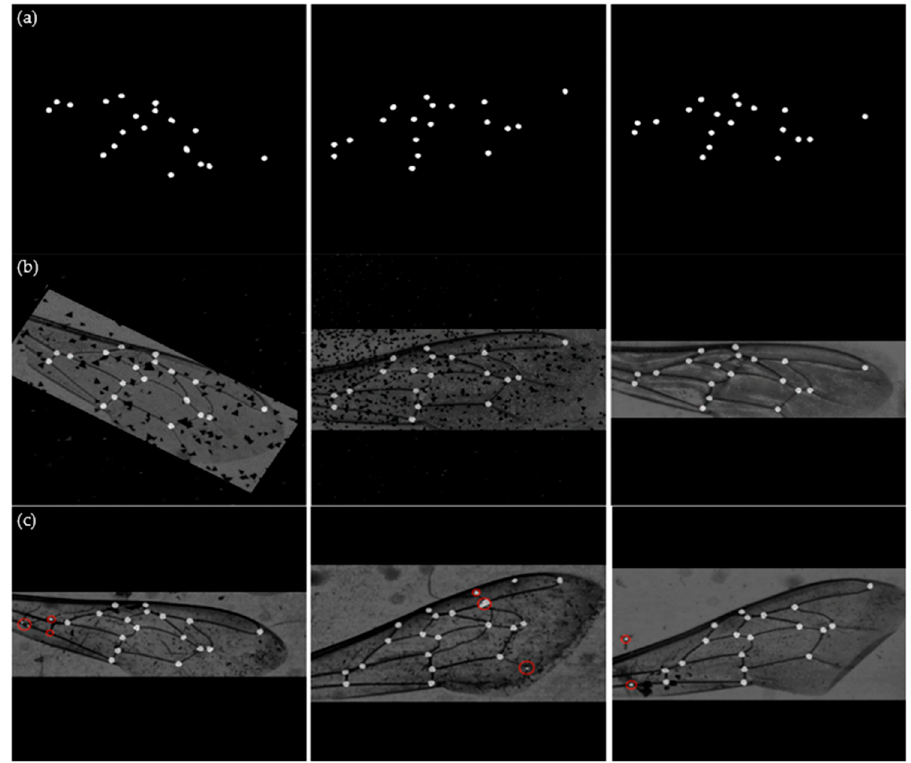
Figure 12. ( a ) The output masks of the U-Net after training. ( b ) Masks superimposed on the corresponding original images. ( c ) Examples of errors, denoted by the red circles, in low-quality images. Table 3. Positional precision of the 19 detected landmarks. The landmarks correspond in nomination to the sequence of annotated numbers shown in Figure